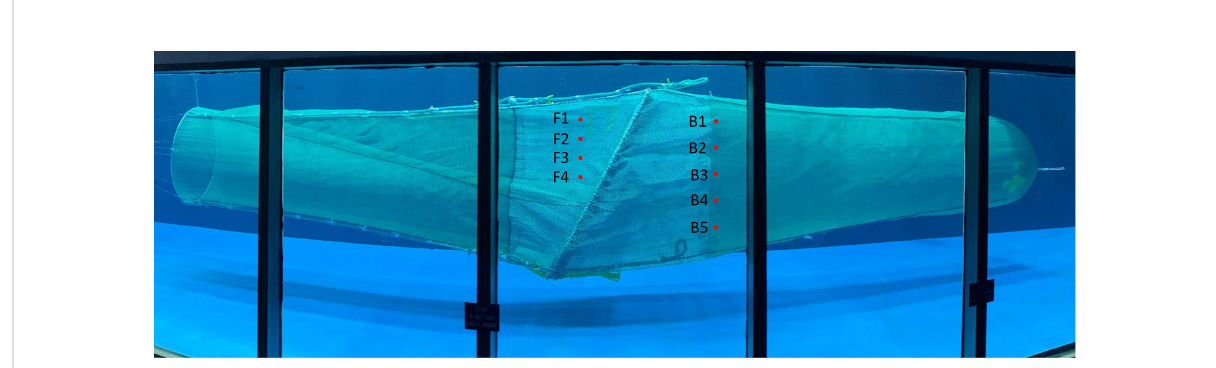
FIGURE 2 Baseline 22-mm bar spacing Nordmøre grid section during fl ume tank testing. Points for fl ow measurements in front (F1, F2, F3, and F4) and behind (B1, B2, B3, B4, and B5) the grid during hydrodynamic testing are